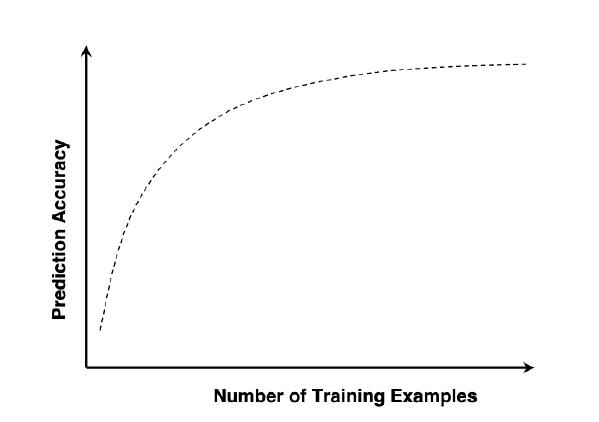
Figure 2. Learning curve showing accuracy versus number of training samples (Perlich, 2010)